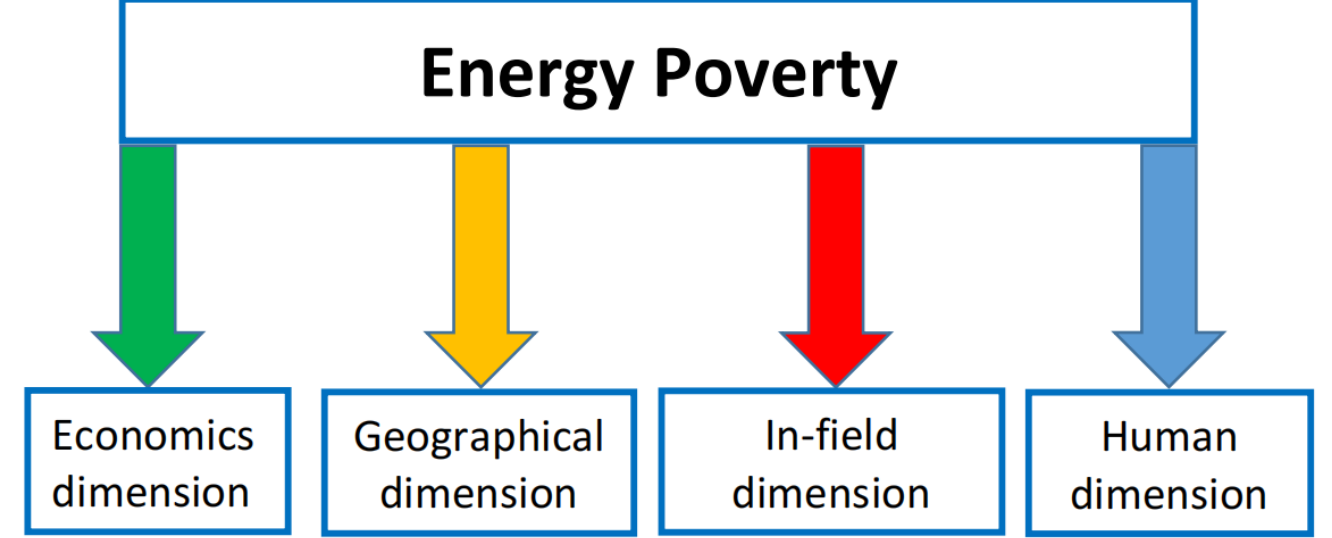
Figure 1. The profile of literature review allocation on energy poverty studies among the four main dimensions of analysis (source: author’s own study).